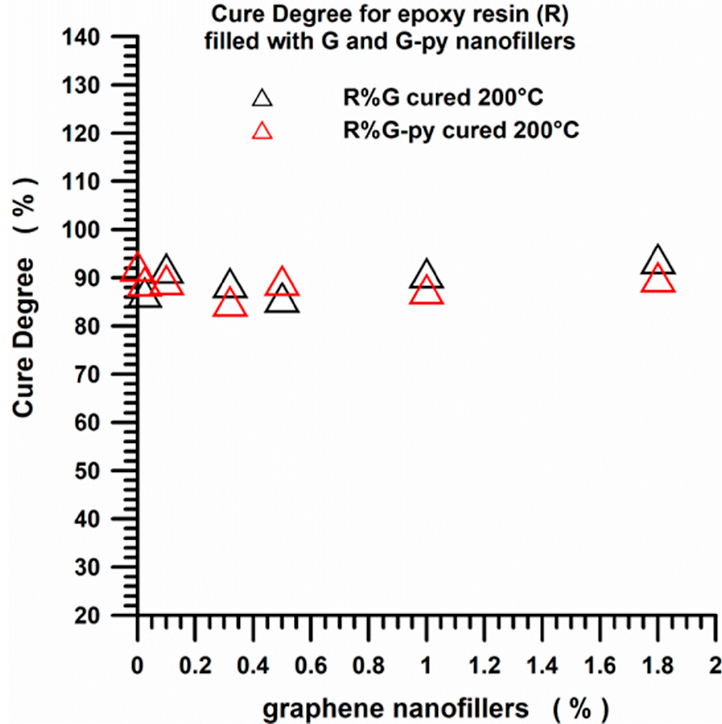
Figure 16. DC values of the pristine G and functionalized G-py based nanocomposites cured under isothermal heating conditions.